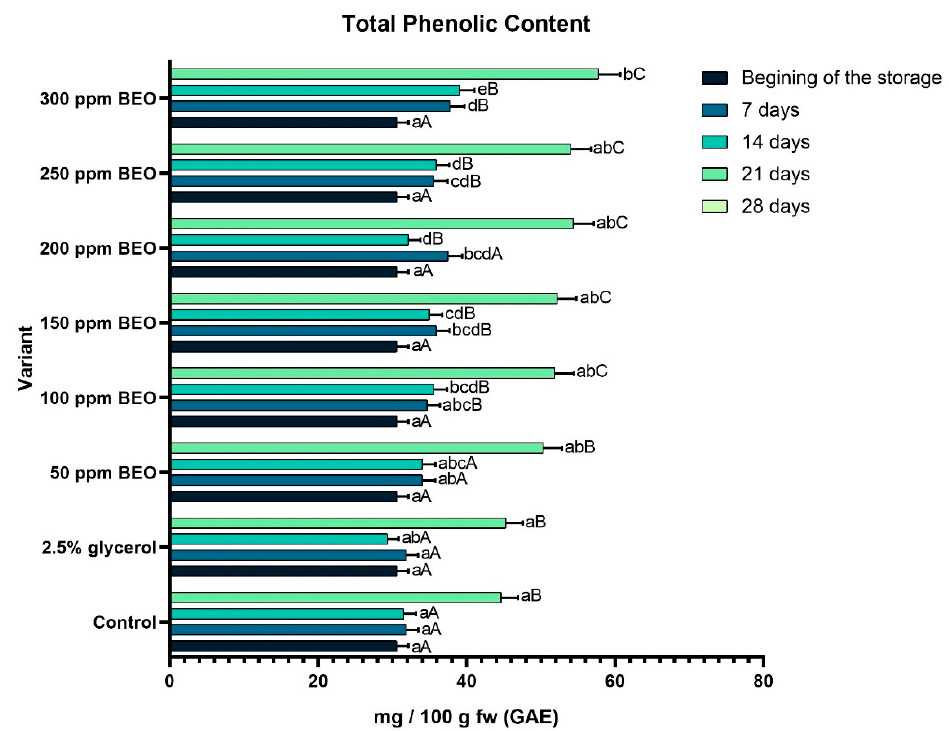
Figure 5. Effects of applied treatments on the total phenolic content (mg GAE /100 g fw) during storage for 21 days at 8 ± 1 °C. Bars for the same sampling time followed by different lowercase letters are significantly different based on the least significant difference (LSD) test ( p < 0.05). Bars for the same treatment during storage time followed by different uppercase letters are significantly different based on the least significant difference (LSD) test ( p < 0.05).